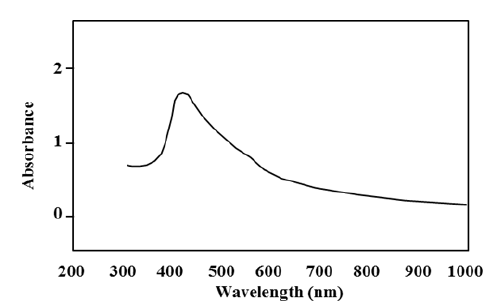
Fig. 1. Cell filtrate of Pseudomonas sp . H64 (before addition of AgNO ) (A); treated with 1mM AgNO 3